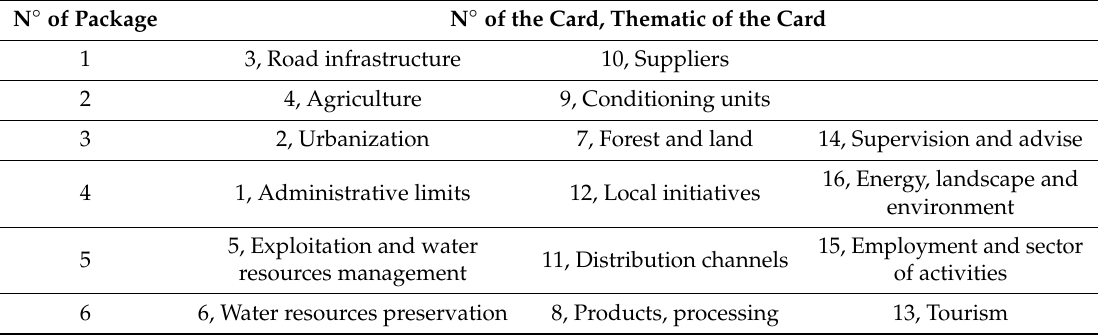
Figure 2. The game supports: the maquette and the playing cards (modified from [26]). Table 1. The playing cards.